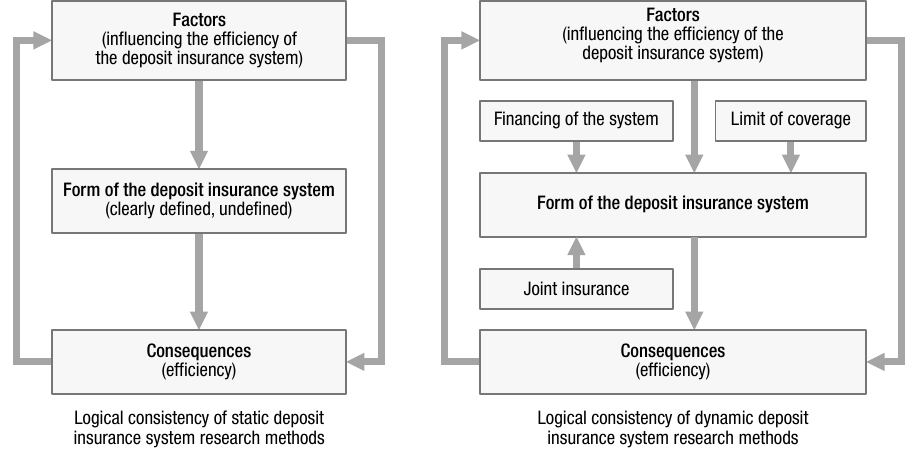
Fig. 2. Logical consistency of static and dynamic deposit insurance system research